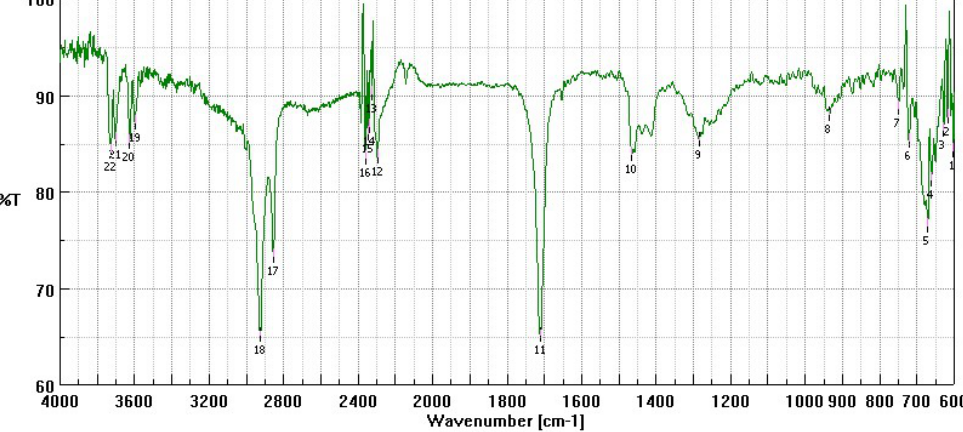
Figure 1. FT-IR spectrum of chitosan-oleate (CS-OA).